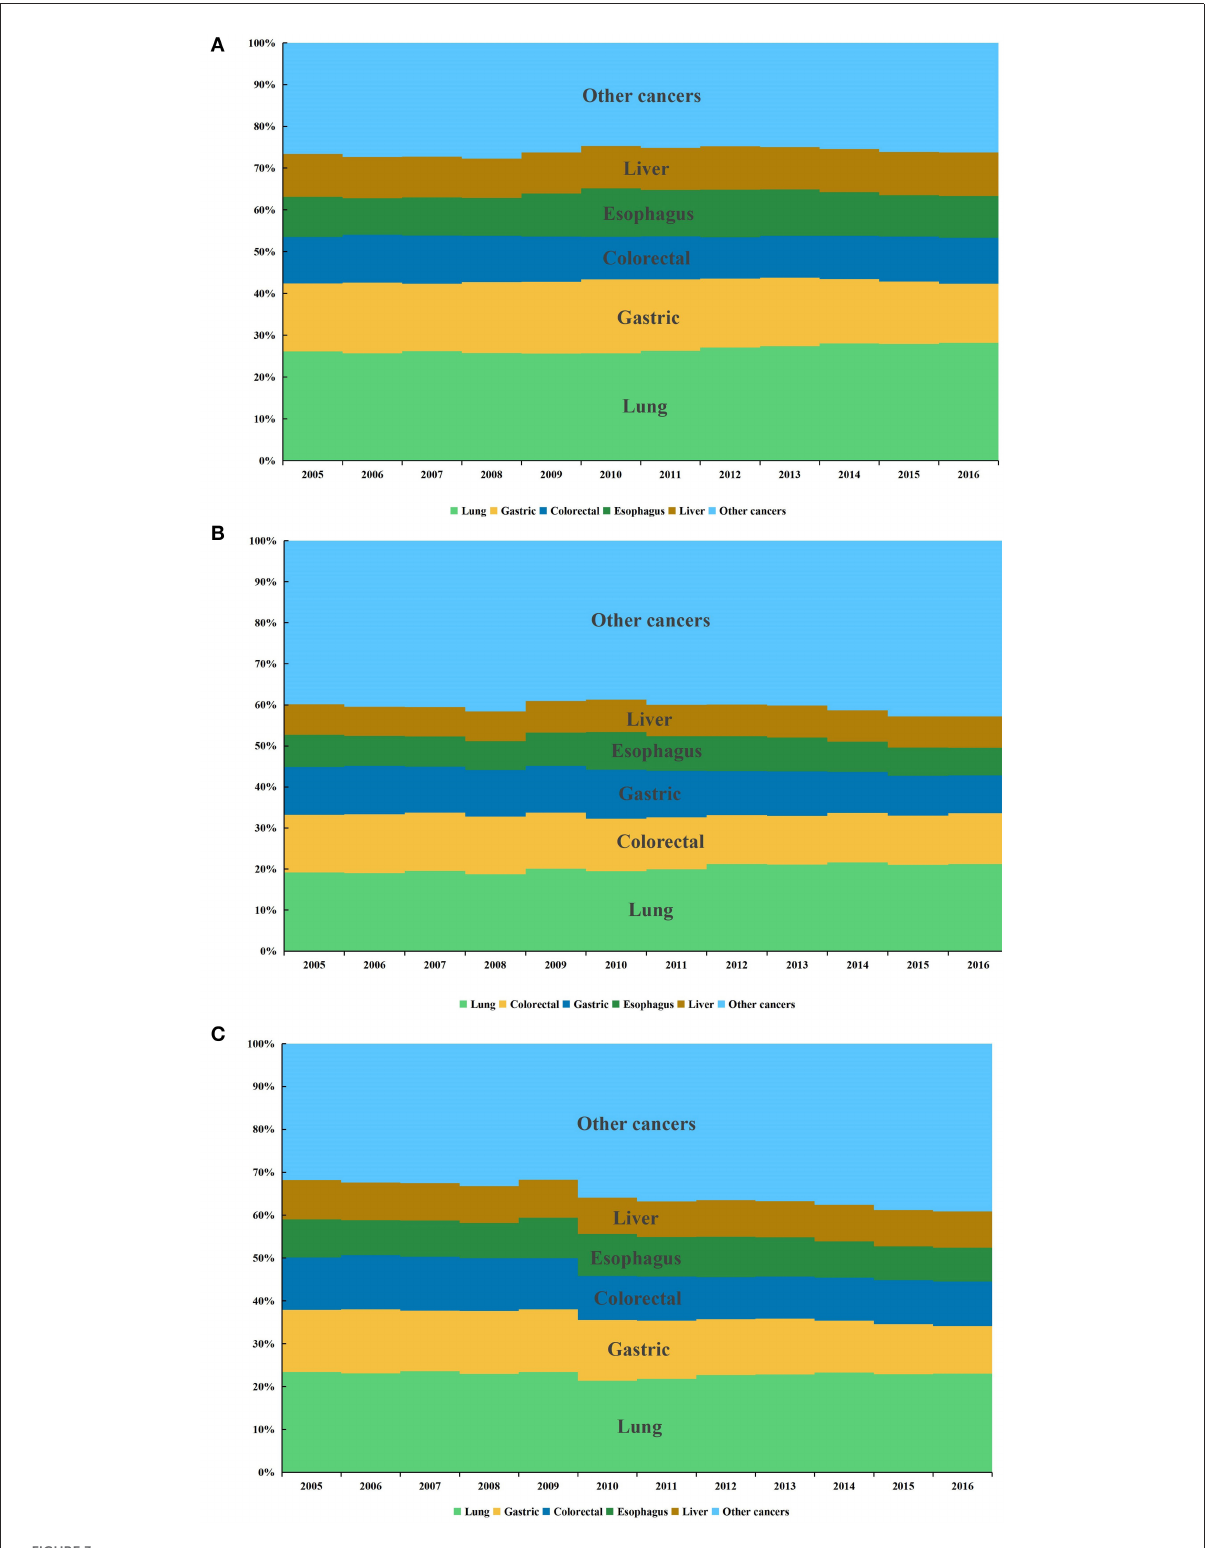
FIGURE3 Composition of cancers in Chinese older adults aged 60 and above from 2005 to 2016. (A) Male. (B) Female. (C)